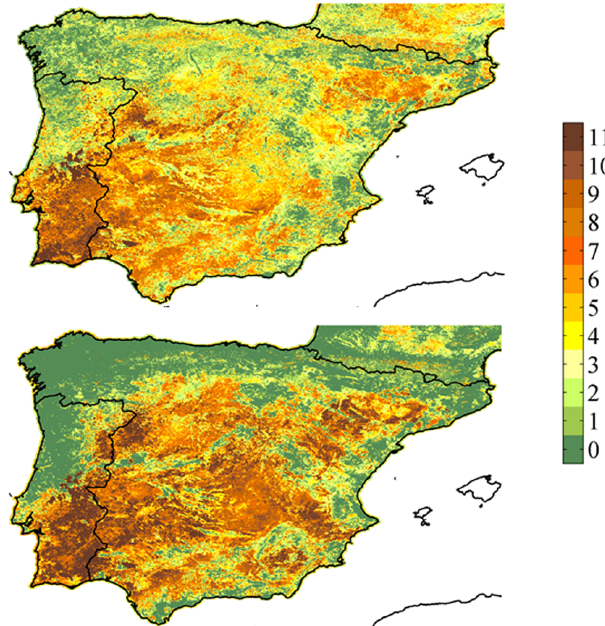
Fig. 4. Number of months between September 2004 and July 2005 characterised by (a) NDVI anomaly values below − 0.025 (top); and (b) NDDI anomaly values above 0.25